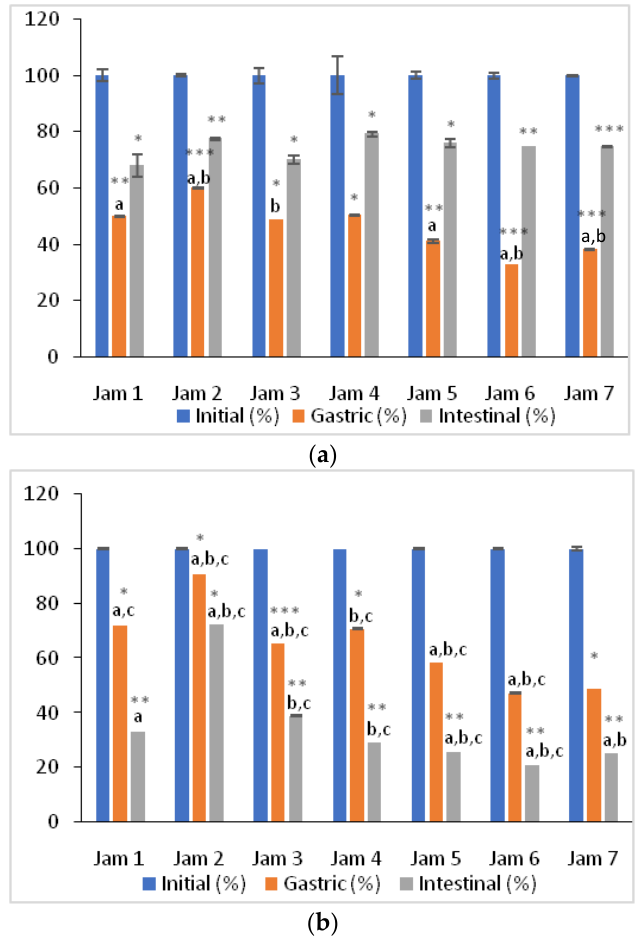
Figure 5. Changes in bioaccessibility(%) of antioxidants by ABTS ( a ) and FRAP ( b ) assays during in vitro simulated digestion of lingonberry jams. Data represent average values ± standard deviation of three independent measurements and initial bioaccessibility determined in non-digested jams is set as 100%. Letters a,b,c indicate statistically significant differences between the values for each phase of digestion ( p < 0.05) according to Student’s t tests. Asterisk symbols signify the following levels of statistical significance of differences according to one way ANOVA and Student’s t tests: